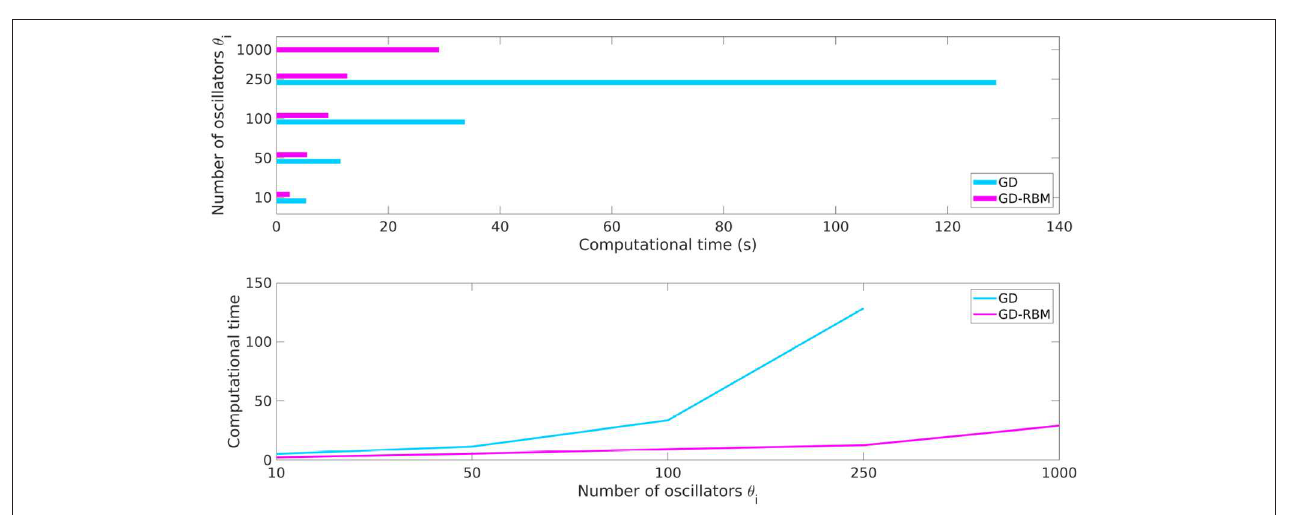
u with increasing values of N b